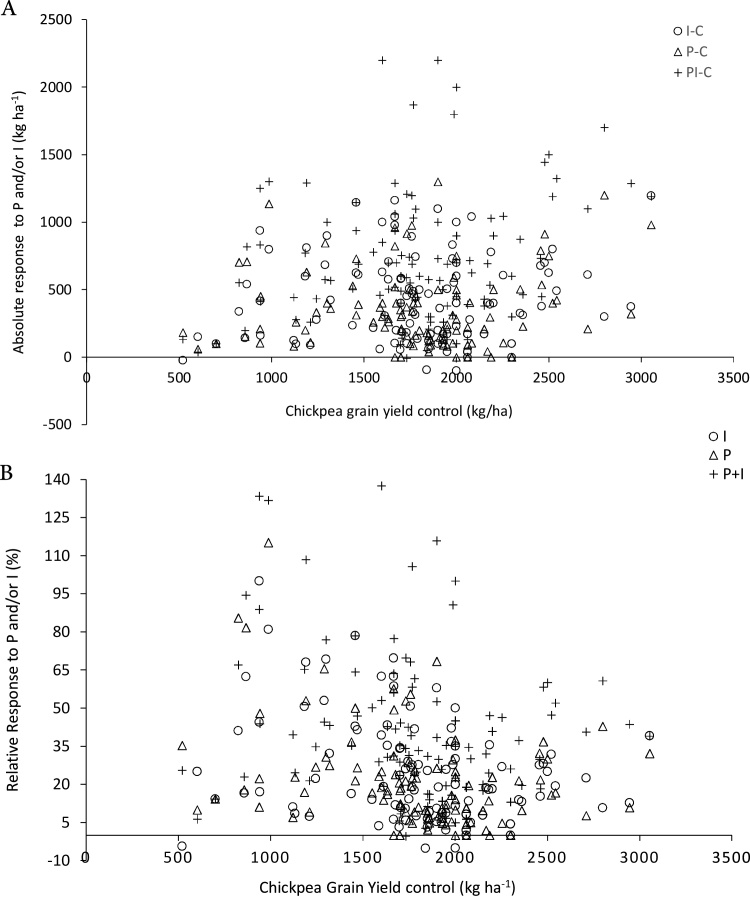
A Chickpea absolute grain yield (kg ha−1) in the control treatment and response to P, I and P + I for individual farms in the target Woredas in Ethiopia (2012–2015) as absolute yield (kg ha−1; yield of P and/or I minus control yield). B Relative response in grain yield of chickpea to P and/or I plotted against the control yield (%, yield of P and/or I minus control yield divided by control yield).